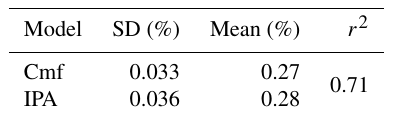
Table 3. Statistical parameters from model comparison between cmf and IPA for inhomogeneous soil.